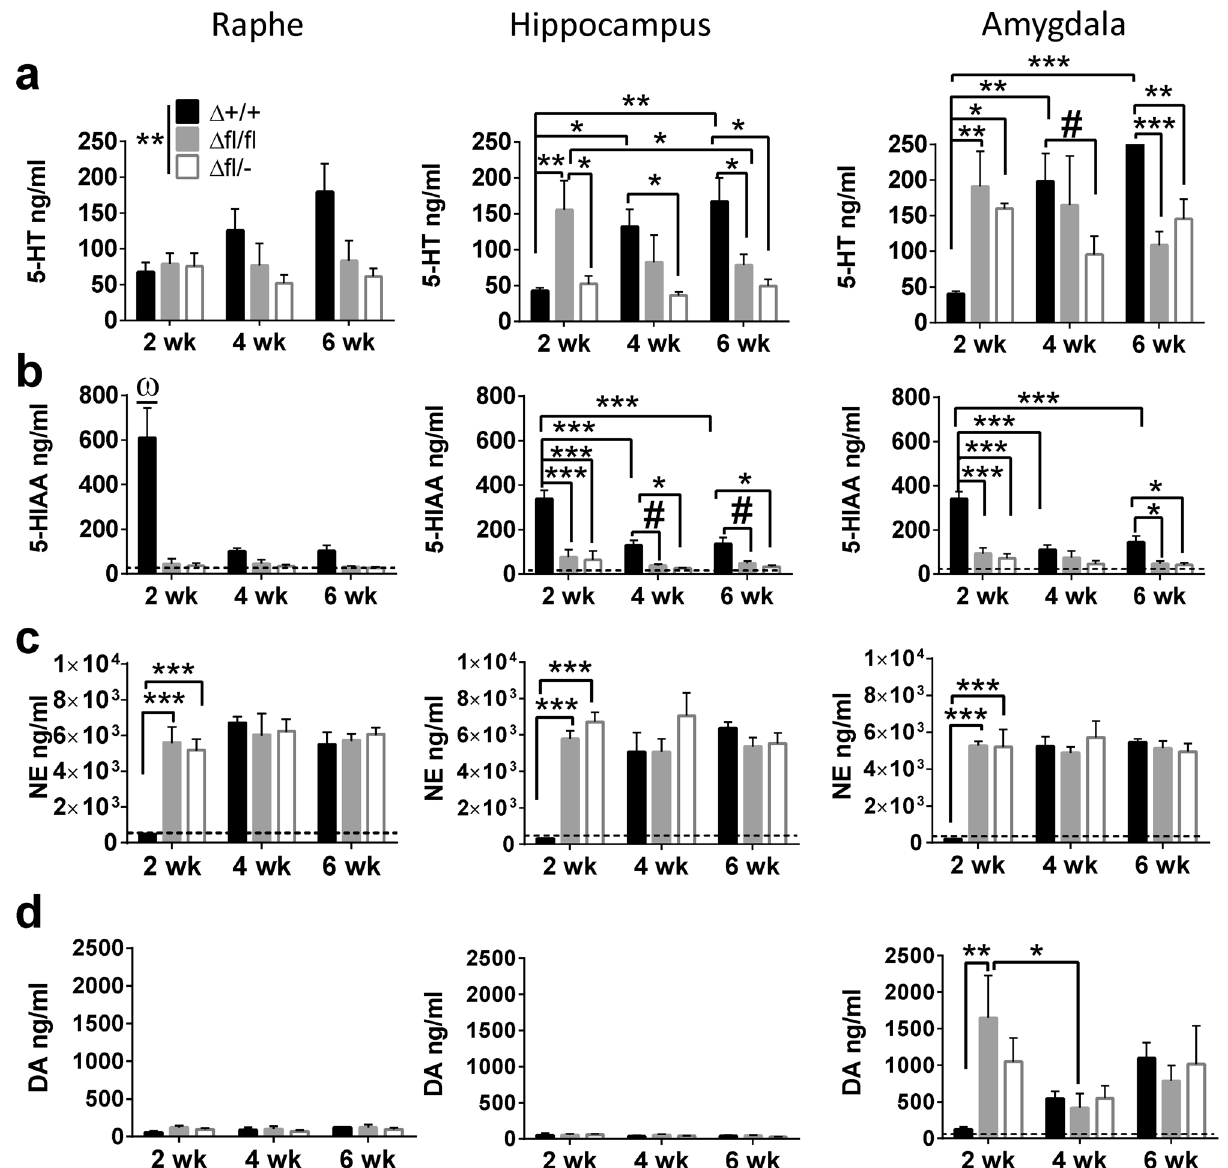
Figure 2. Concentrations of monoamines in brain of Tph2 induced conditional knockout mice ( Tph2 +/+ , Tph2 fl / fl , Tph2 fl /− ). HPLC analysis of 5-HT in raphe, hippocampus and amygdala at week (wk) 2, 4 and 6 after induction; ( a ) 5-HT, ( b ) 5-HIAA, ( c ) NE, ( d ) DA in selected brain regions. Data are shown as mean ± SEM. # 0.05 < p < 0.1, ** p < 0.01, *** p < 0.001 and ω p < 0.001 compared to all